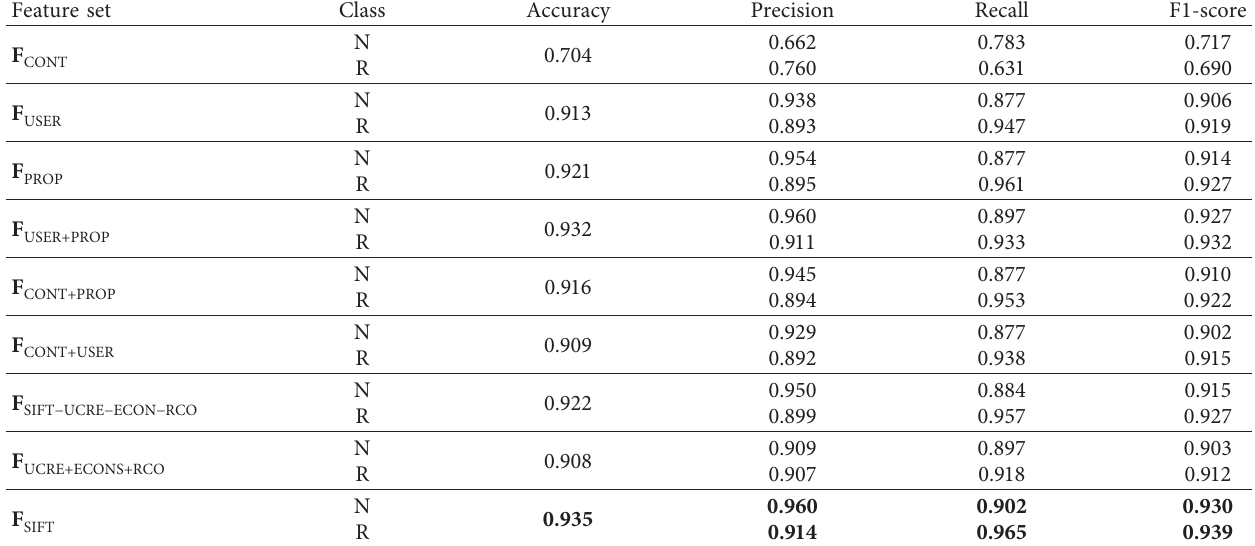
Table 3: Feature set comparison results.